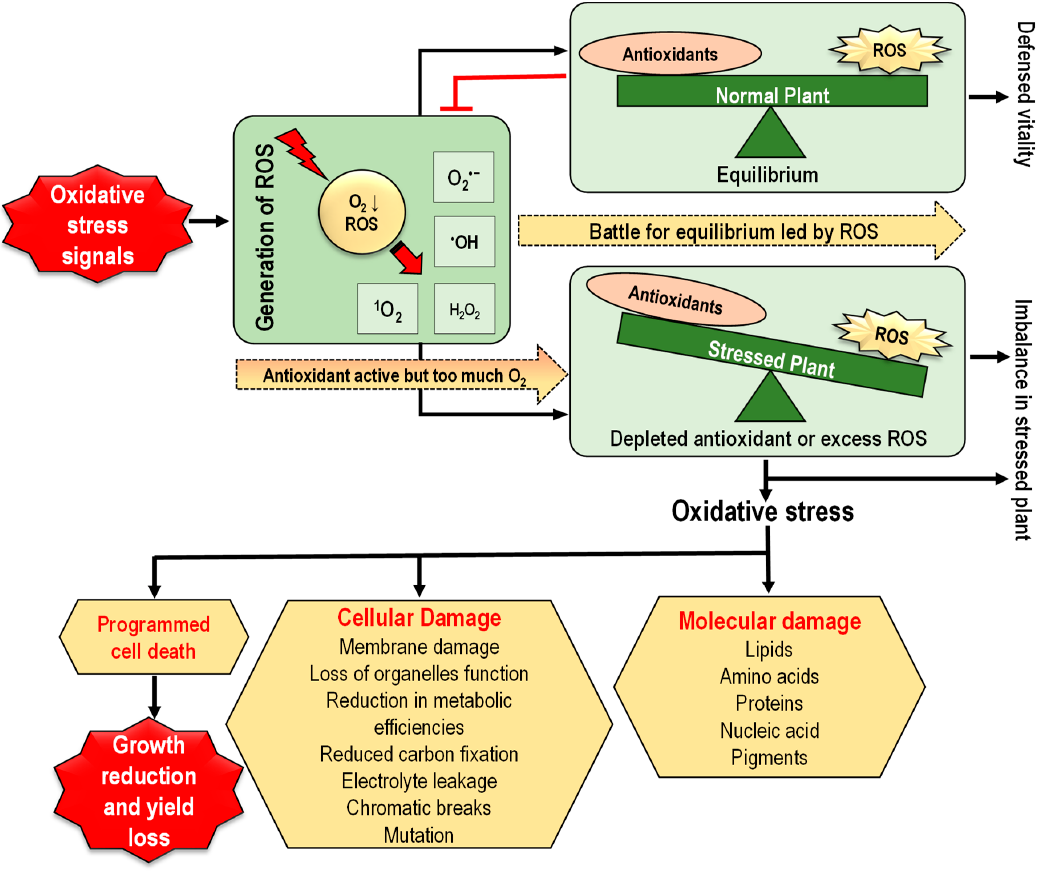
Figure 4. Oxidative stress in plants and its consequences (ROS, reactive oxygen species; 1 O 2 , singlet